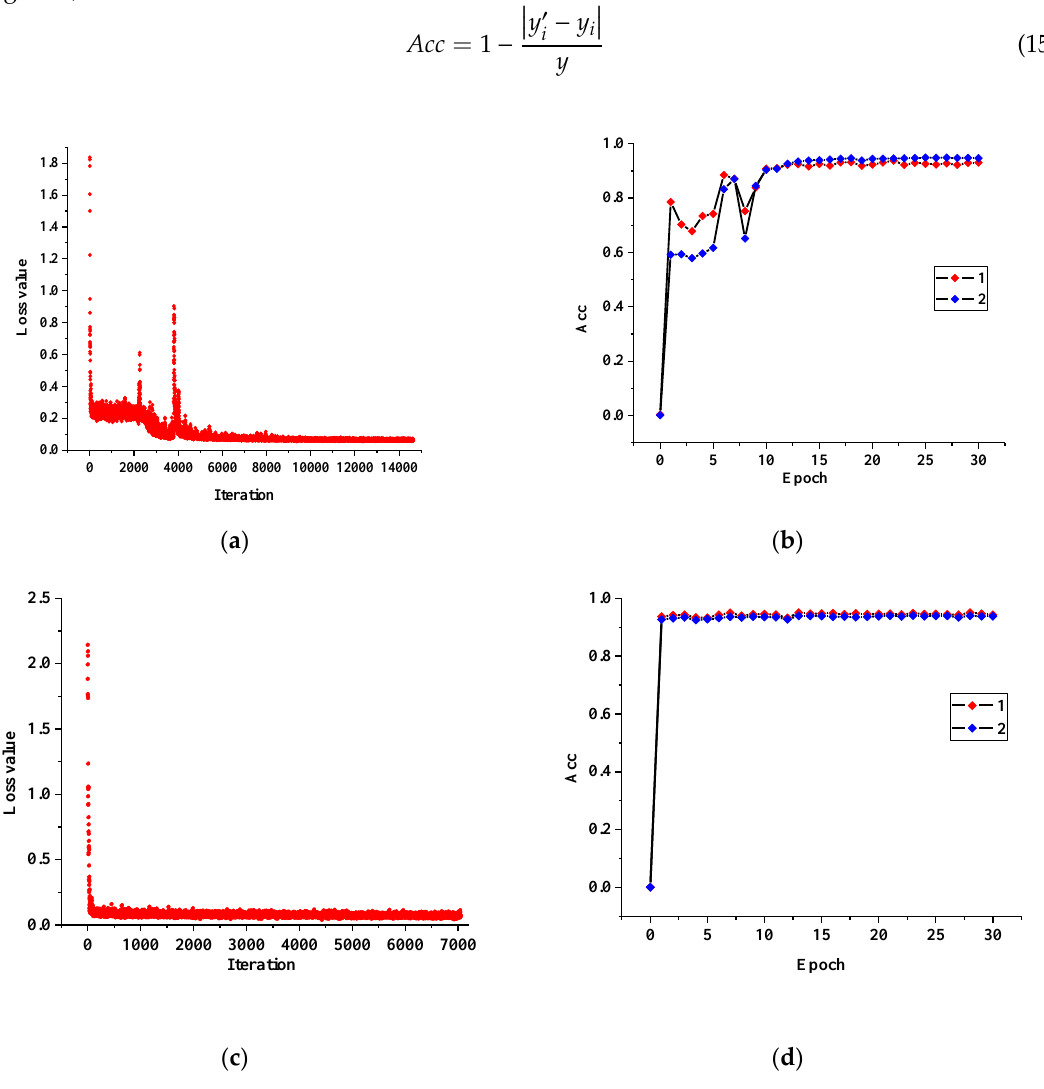
Figure 4. Model training process of MLP and CNN. ( a ) Loss function of MLP; ( b ) Acc of MLP; ( c ) Loss function of CNN; ( d ) Acc of CNN.